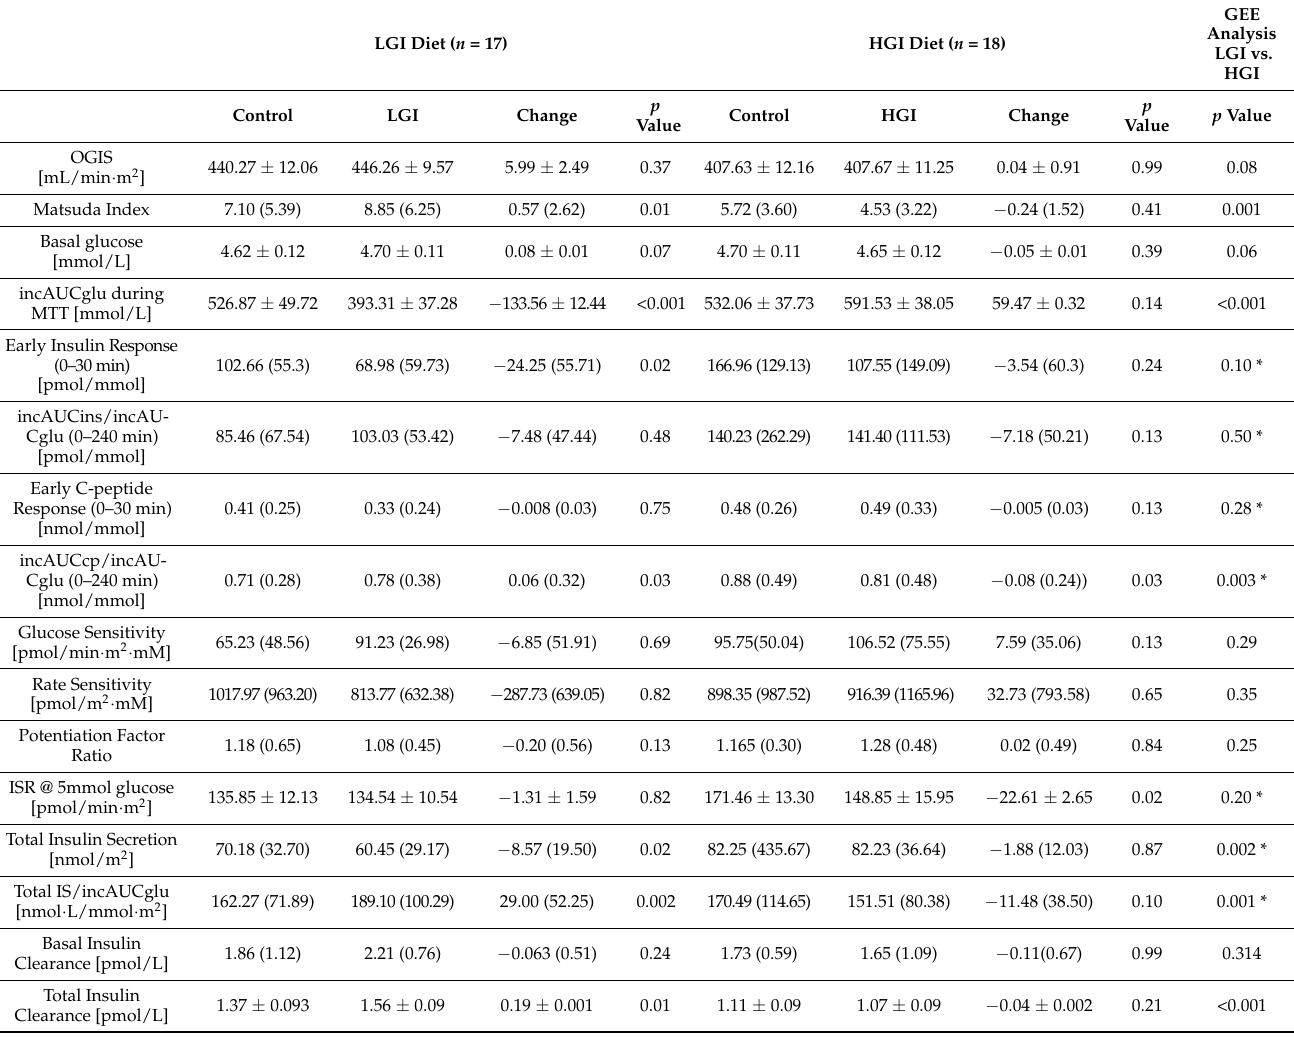
Table 2. MTT Metabolic Outcomes by Diet